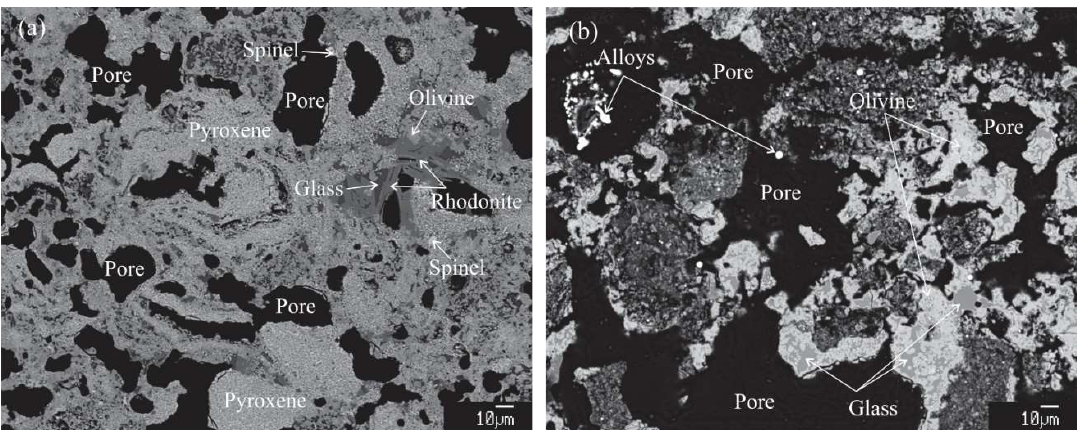
Figure 5. Microstructure of reduction sample after pre-reduction at 1000 °C for 60 min: ( a ) sample ND2 with 1.2% graphite addition; ( b ) sample ND9 with 4% graphite addition.